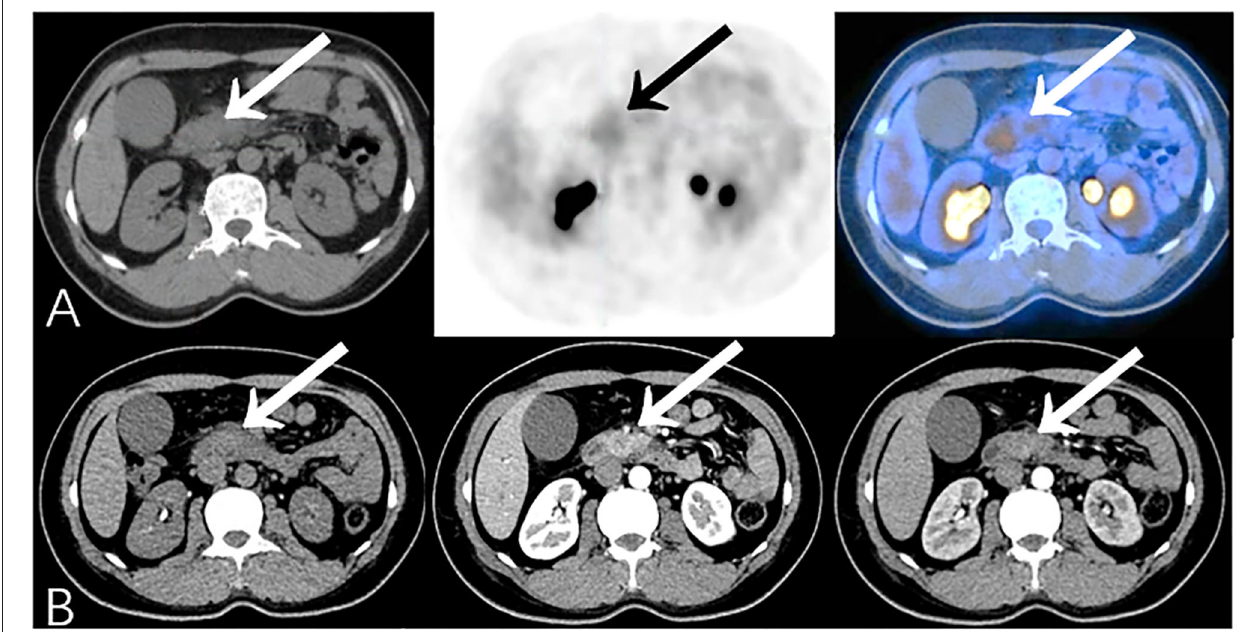
FIGURE 6 | Additional findings on PET/CT (True-Positive) compared to CECT (False-Negative): A 45-year-old female experienced jaundice with abdominal pain for 2 months. Serum CA19-9 was elevated (926.7 U/ml). (A) PET/CT showed focal 18 F-FDG uptake in the head of the pancreas (SUVmax 3.6). (B) CECT only showed obstruction, calcification, and the atrophy of pancreatic parenchyma subsequent to chronic pancreatitis. Patient then underwent pancreaticoduodenectomy, and histopathology revealed moderately-differentiated pancreatic ductal adenocarcinoma complicated with chronic pancreatitis.